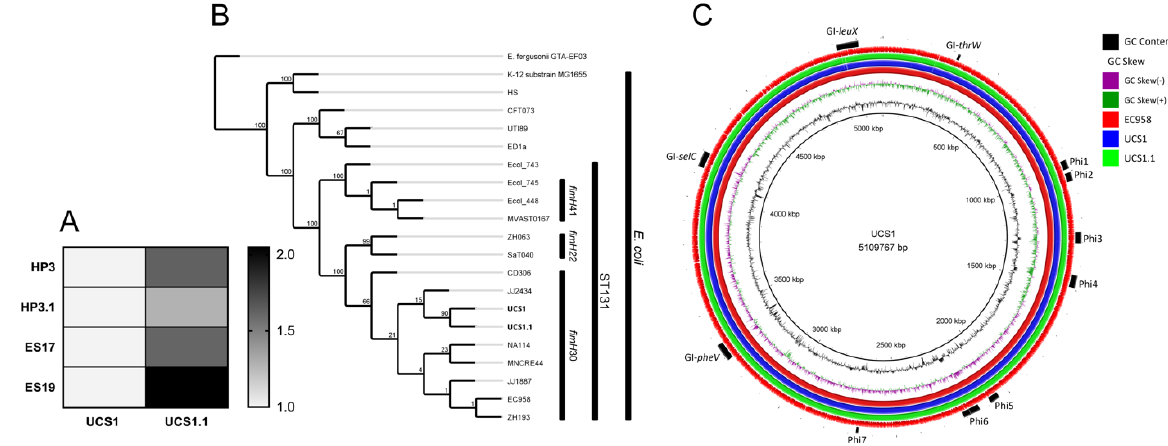
Figure 4. UCS1 and UCS1.1 are nearly identical ST131 strains. ( A ) Purified phages HP3, HP3.1, ES17, and ES19 were tittered onto lawns of UCS1 and UCS1.1. Efficiency of Plating (EOP) was calculated using UCS1 as the reference strain (EOP = 1). n = 3 technical replicates. ( B ) Phylogenetic tree was generated using autoMLST and visualized using Geneious Prime. UCS1 and UCS1.1 are shown in the context of other ST131 strains from the three major subtypes ( fimH 22, fimH 30, and fimH 41) and strains from other relevant UPEC sequence types: CFT073 (ST73) and UTI89 (ST95). Nodes are annotated with Ultrafast Bootstrap values. ( C ) Circular genome visualization created using BLAST Ring Image Generator (BRIG). EC958 acted as reference genome. Rings from inner to outer are as follows: (1) GC Content, (2) GC skew, (3) E. coli EC958 (Red), (4) E. coli UCS1 (Blue), (5) E. coli UCS1.1, and (6) CDS features (from EC958).